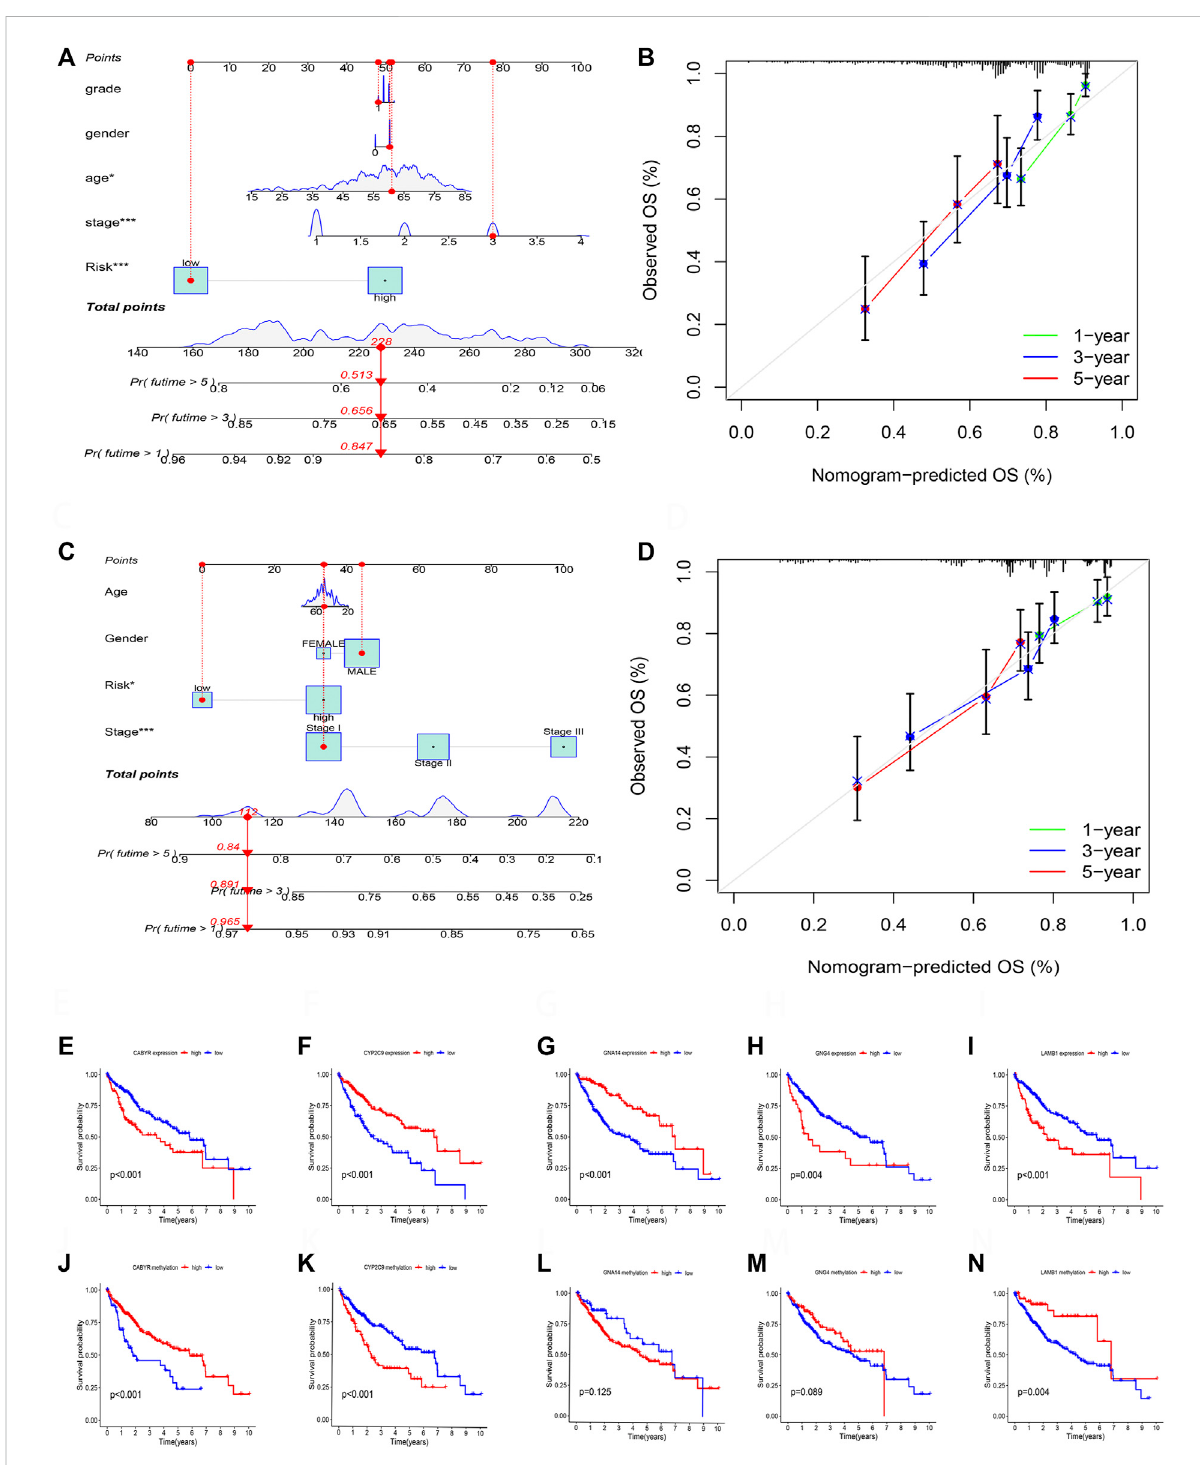
FIGURE 11 (A) The nomogram integrated the risk score and clinical features to predict the survival rate of the 1, 3, and 5 years in TCGA cohort. (B) The 1, 3, and 5 years OS calibration curves in TCGA cohort. (C) The nomogram integrated the risk score and clinical features to predict thesurvival rate of the 1,3,and5 yearsinGSE14520cohort. (D) The1,3,and5 yearsOScalibrationcurvesinGSE14520cohort. (E) SurvivalanalysisofCABYRexpression. (F) Survival analysis of CYP2C9 expression. (G) Survival analysis of GNA14 expression. (H) Survival analysis of GNG4 expression. (I) Survival analysis ofLAMB1expression. (J) SurvivalanalysisofCABYRmethylationlevel. (K) SurvivalanalysisofCYP2C9methylationlevel. (L) SurvivalanalysisofGNA14 methylation level. (M) Survival analysis of GNG4 methylation level. (N) Survival analysis of LAMB1 methylation